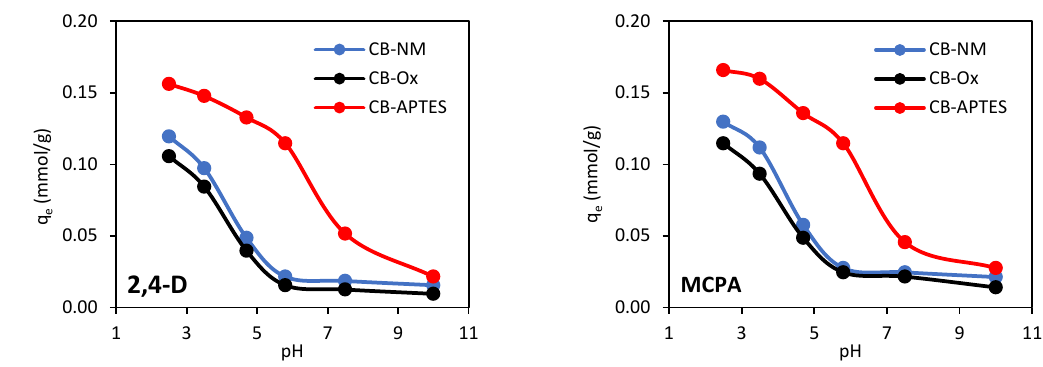
Figure 5. Effect of solution pH on the adsorption of the herbicides on carbon black samples. The course of the q e = f (pH) dependence curves is very similar for both adsorbates, which is due to their similar physicochemical properties. The pK a value for 2,4-D is 2.98, and for MCPA, it is 3.14 (Table 1). This means that in solutions with pH < pK a ,